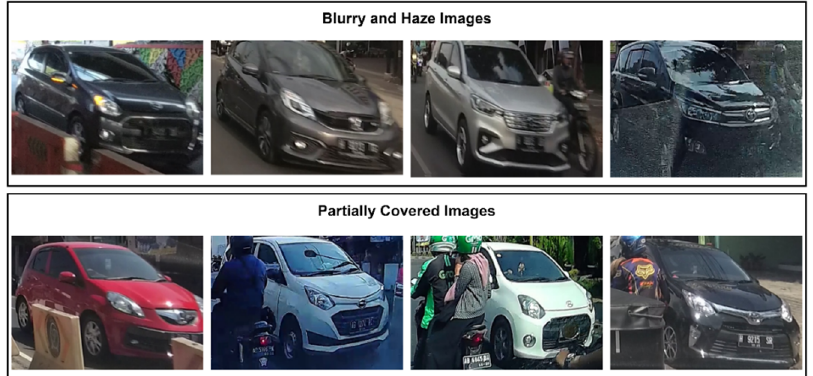
Figure 2. Some examples of challenging images contained in the InaV-Dash Dataset.